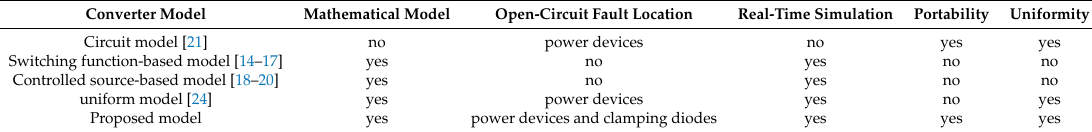
Table 8. Comparison between proposed model and existing